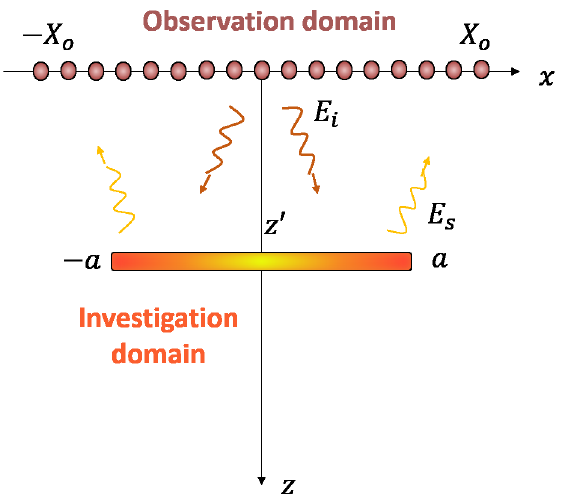
Figure 1. Geometry of the